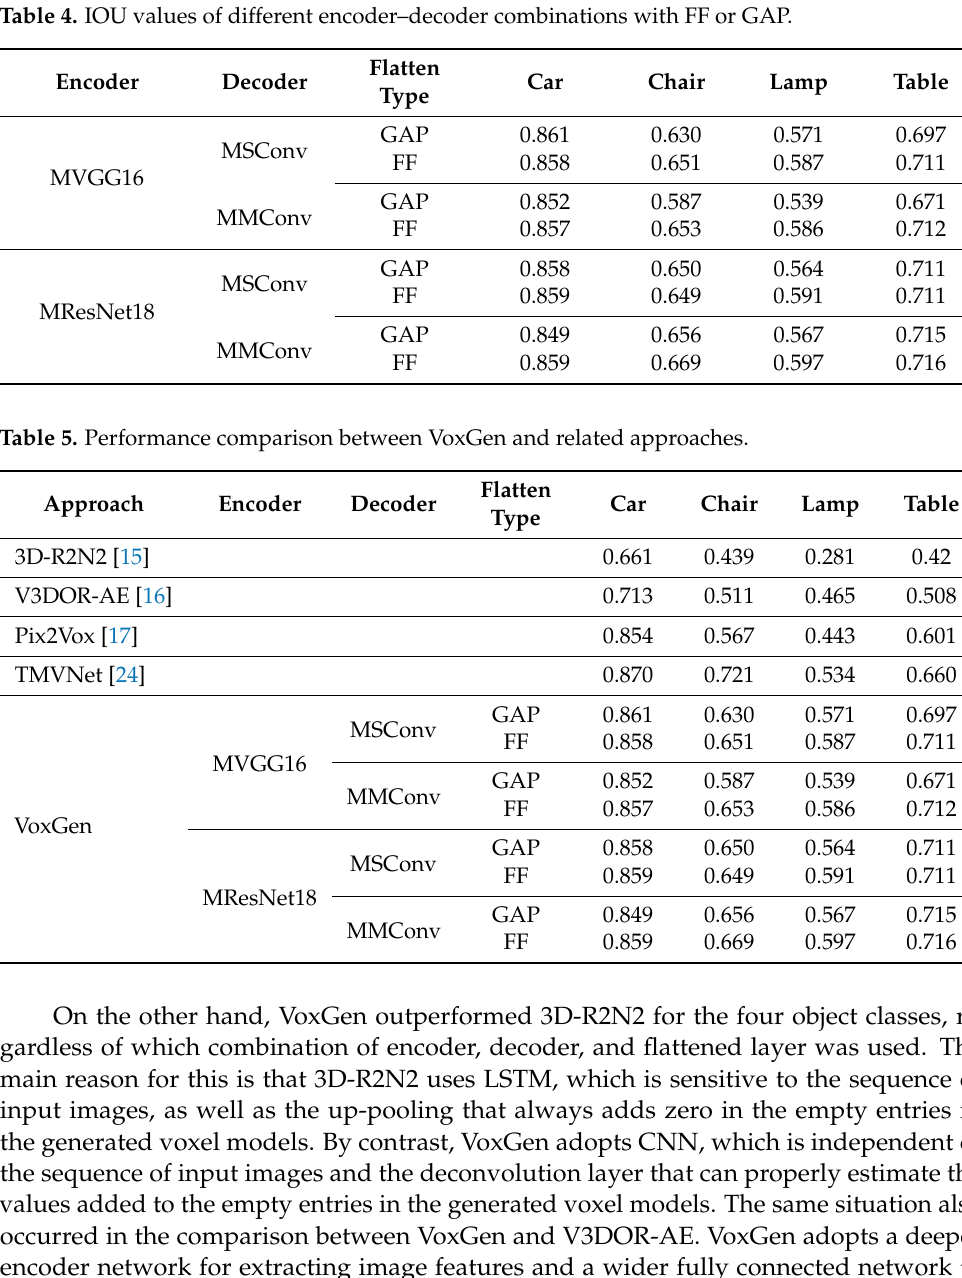
Flatten Car Chair Lamp Type